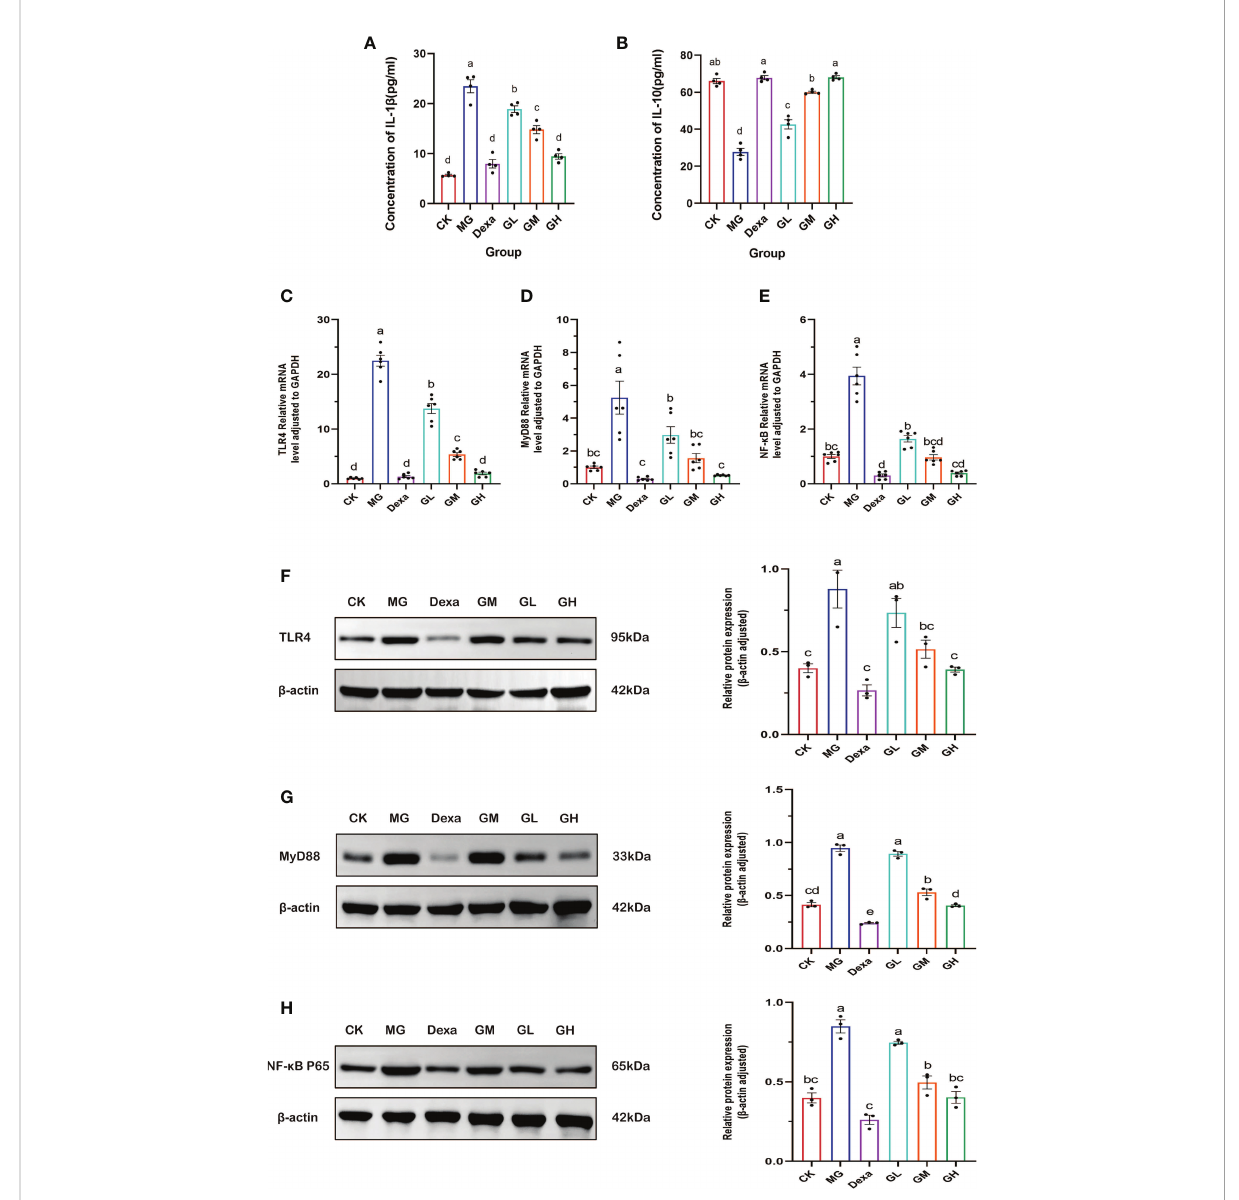
FIGURE 5 The expression level of in fl ammatory factors as detected by ELISA. (A) IL-1 b content. (B) IL-10 content. (C – E) RT-qPCR was used to detect the relative mRNA expression of the genes encoding TLR4 , MyD88 , and NF- k B . (F – H) WB was used to detect the relative expression of the proteins TLR4, MyD88, and NF- k B. A letter common to two groups indicates a signi fi cant difference ( p > 0.05). The absence of a common letter between two groups indicates a p -value of